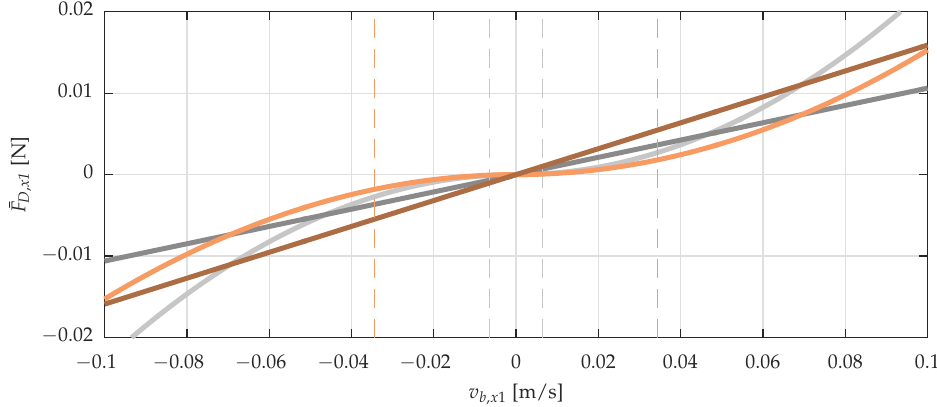
Figure 5. Nonlinear (light) and linearized (dark) horizontal Morison drag force component ¯ F D , x 1 for two sea states, LC 7 (grey) and LC 9 (orange) of [39] with indication of velocity